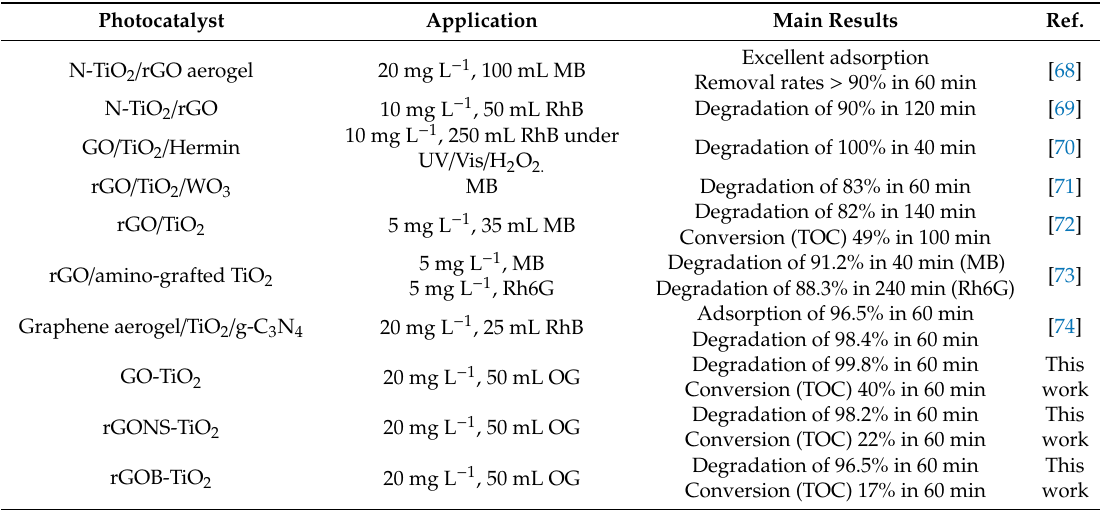
Table 3. Compilation of recently published works regarding graphene-TiO 2 based photocatalysts for dye degradation under visible light illumination.